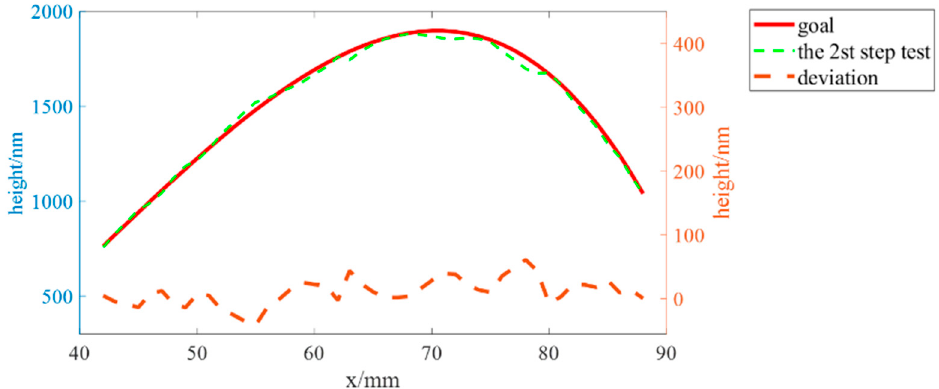
Figure 15. Comparison of the second film thickness distribution with the ideal thickness distribution.